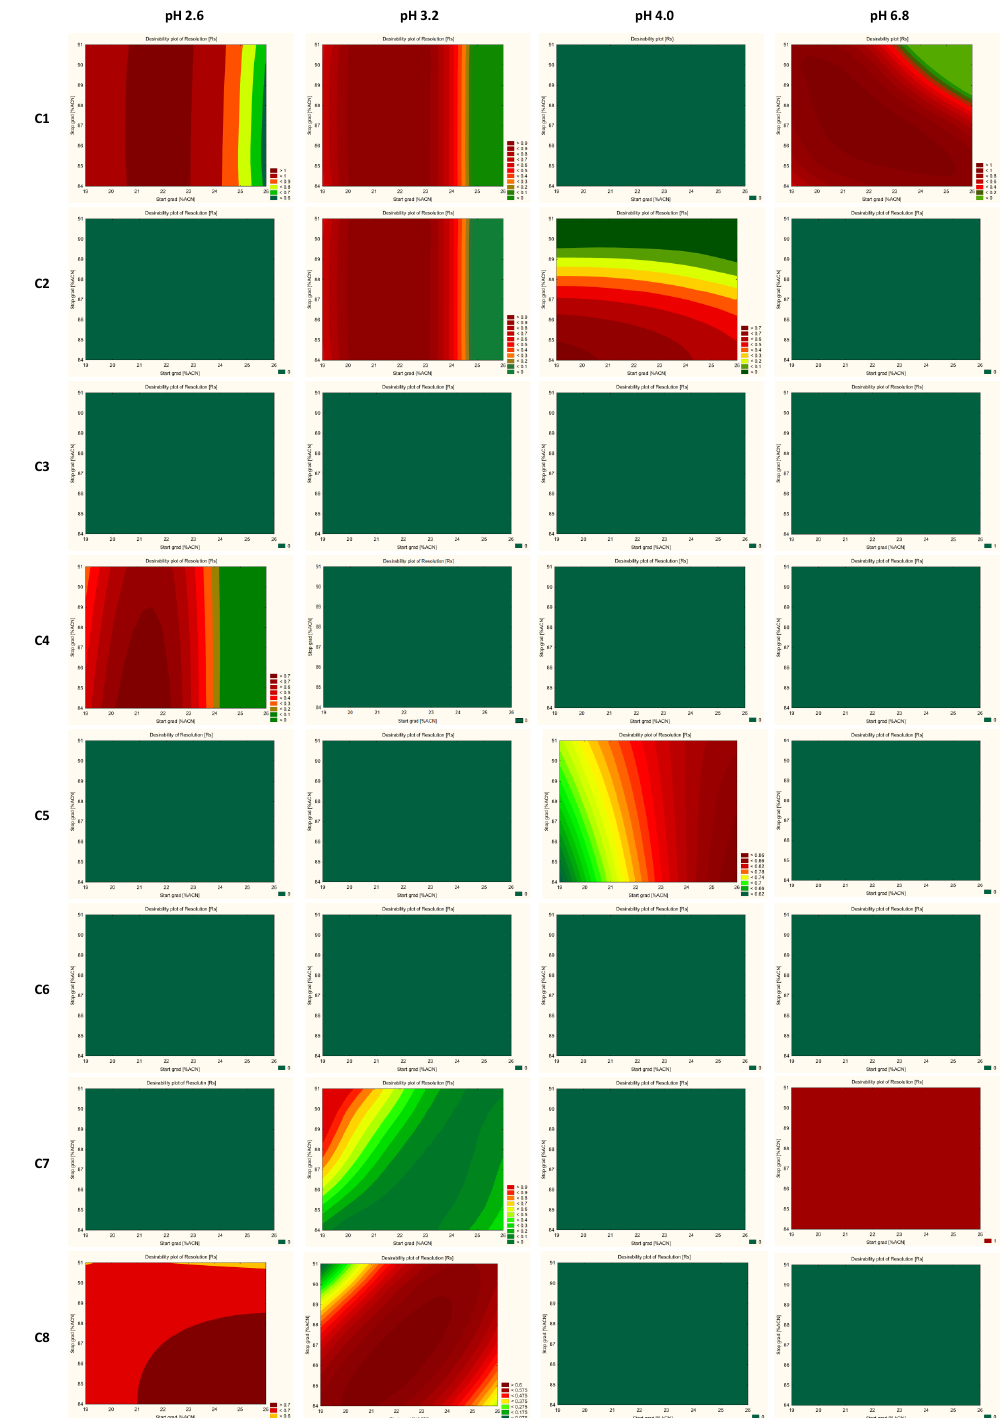
Figure 4. Screening experiment results showing the interaction effect of columns, % of organic solvent at the start and end gradient, and pH with CMAs as a desirability plot of resolutions (R S ). C1—ZORBAX Eclipse Plus C18 (2.1 × 50 mm, 1.8 µ m, Agilent Technologies), C2—Kinetex EVO C18 (2.1 × 50 mm, 1.7 µ m, Phenomenex), C3—ACQUITY UPLC BEH C18 (2.1 × 50 mm, 1.7 µ m Waters), C4—InfinityLab Poroshell 120 Phenyl Hexyl (2.1 × 50 mm, 1.9 µ m, Agilent Technologies), C5—Kinetex Biphenyl (2.1 × 50 mm, 1.7 µ m, Phenomenex), C6—Kinetex PFP (2.1 × 50 mm, 1.7 µ m, Phenomenex), C7—ACQUITY UPLC CSH C18 (2.1 × 50 mm, 1.7 µ m, Waters), and C8—ACQUITY UPLC CSH Fluoro-Phenyl (2.1 × 100 mm, 1.7 µ m,